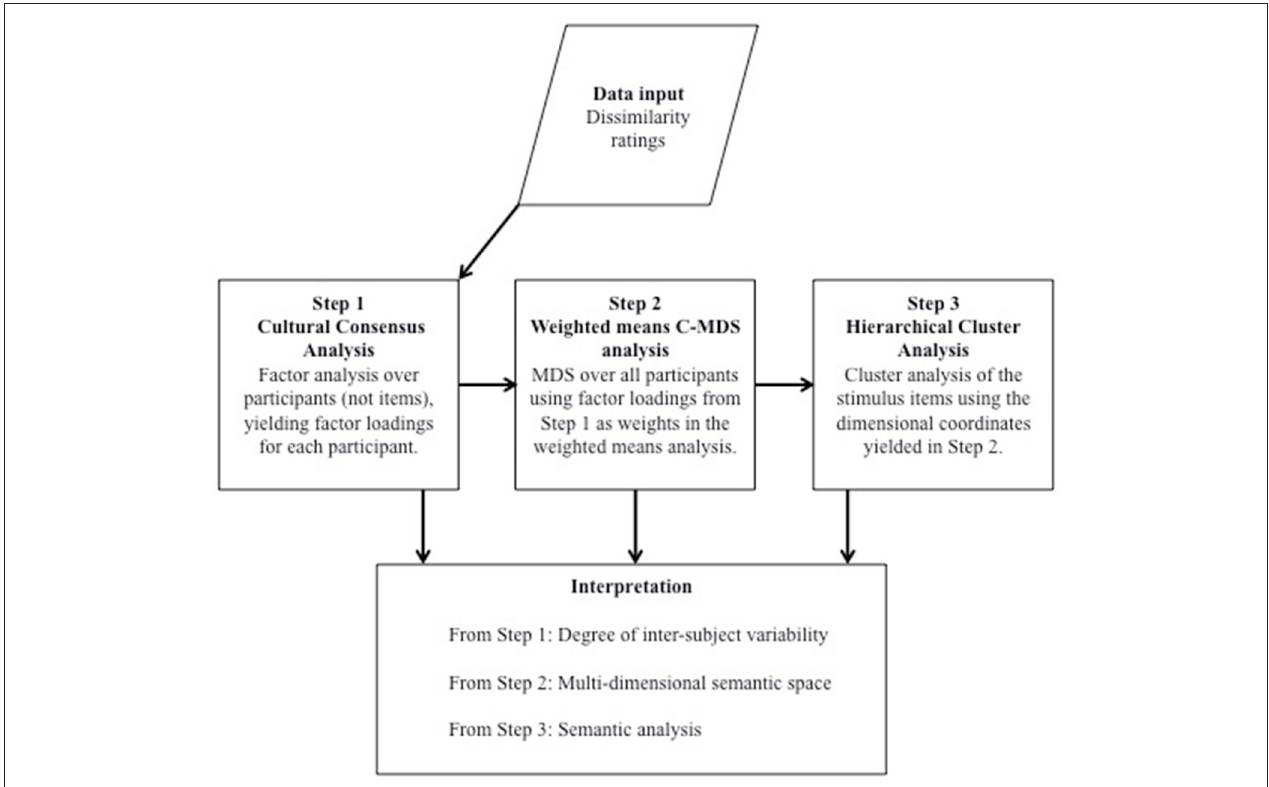
FIGURE 3 | Summary of the steps involved in the augmented classic multi-dimensional scaling (C-MDS) analysis employed in this study (see text for details).